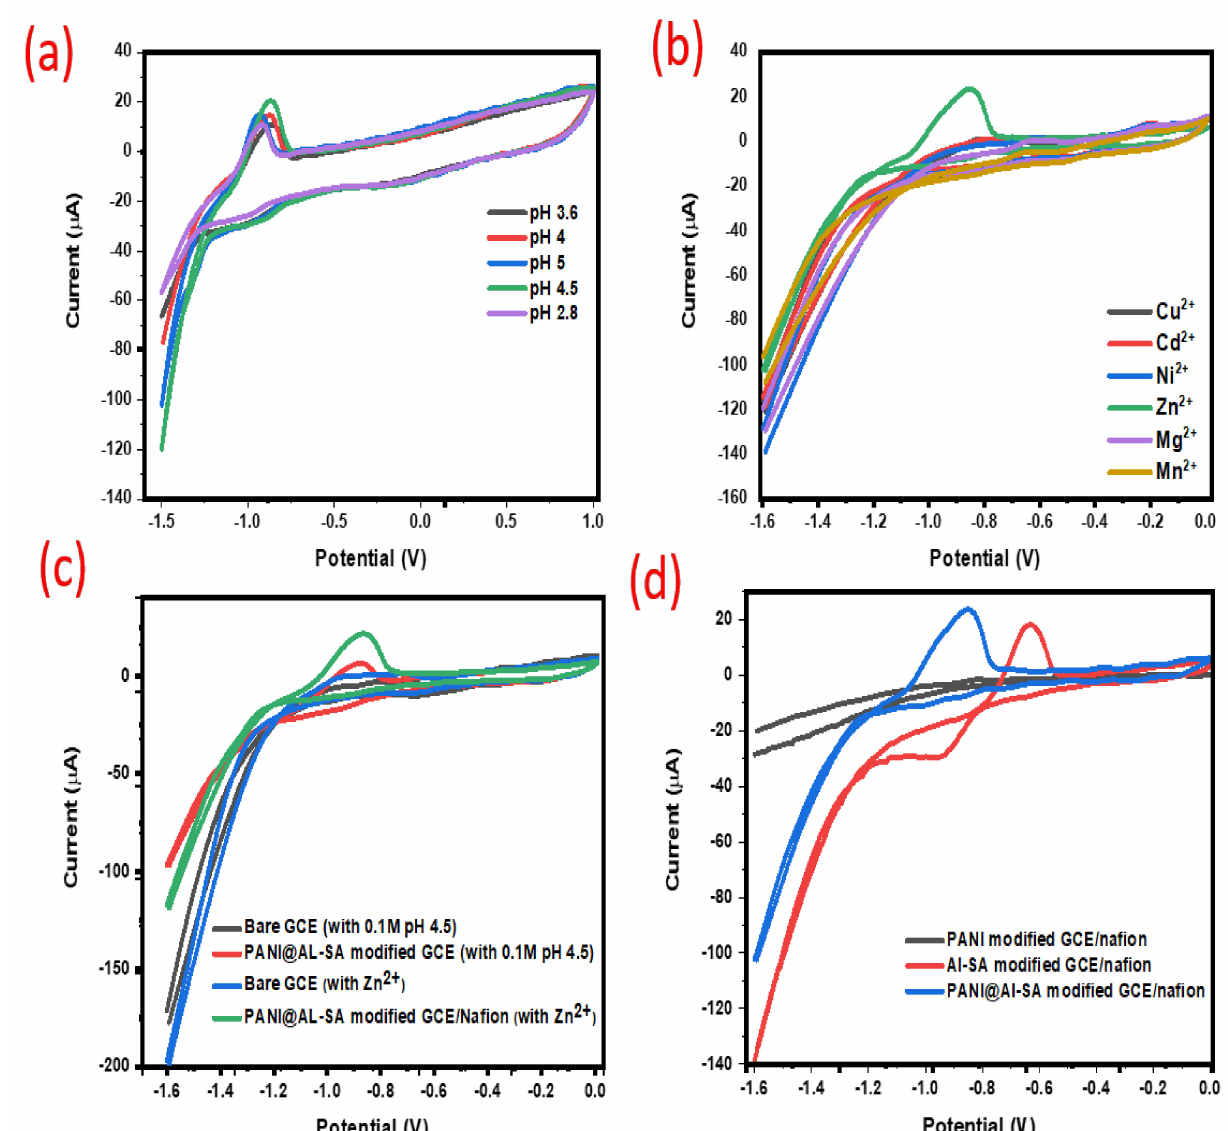
Figure 7. ( a ) CV response of 0.03 mM Zn 2+ in pH solutions at a scan rate of 100 mV/s. ( b ) Comparative CV response of PANI@Al-SA/nafion modified GCE toward 0.03 mM of different metal ions in acetate buffer solution at pH 4.5 at a scan rate of 100 mV/s. ( c ) Cyclic voltammograms of response of bare and PANI@Al-SA/nafion modified GCE in the presence and absence of 0.03 mM Zn 2+ in acetate buffer solution at pH 4.5 at a scan rate of 100 mV/s ( d ) Comparative CV response of PANI@Al-SA/nafion with its constituents in acetate buffer at pH 4.5 containing 0.03 mM of Zn 2+ at scan rate of 100